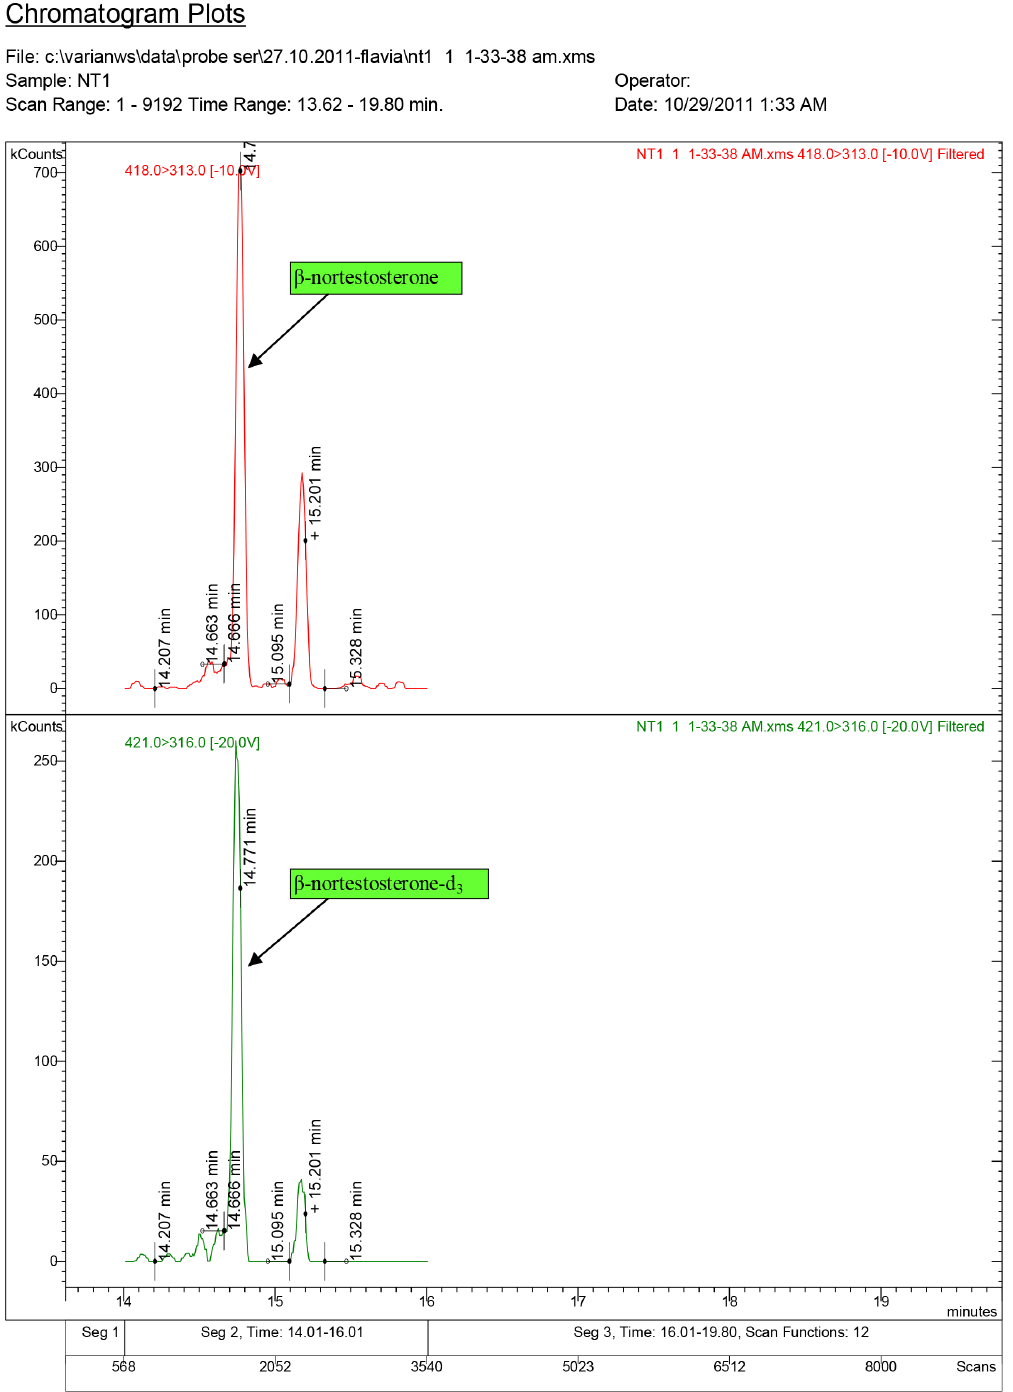
Figure 10. Diagnostic ions for serum sample NT1, where 17 b -nortestosterone was quantified at 1.57 ng/ml (ND1 dose: 1.5 mg/ kg.bw).